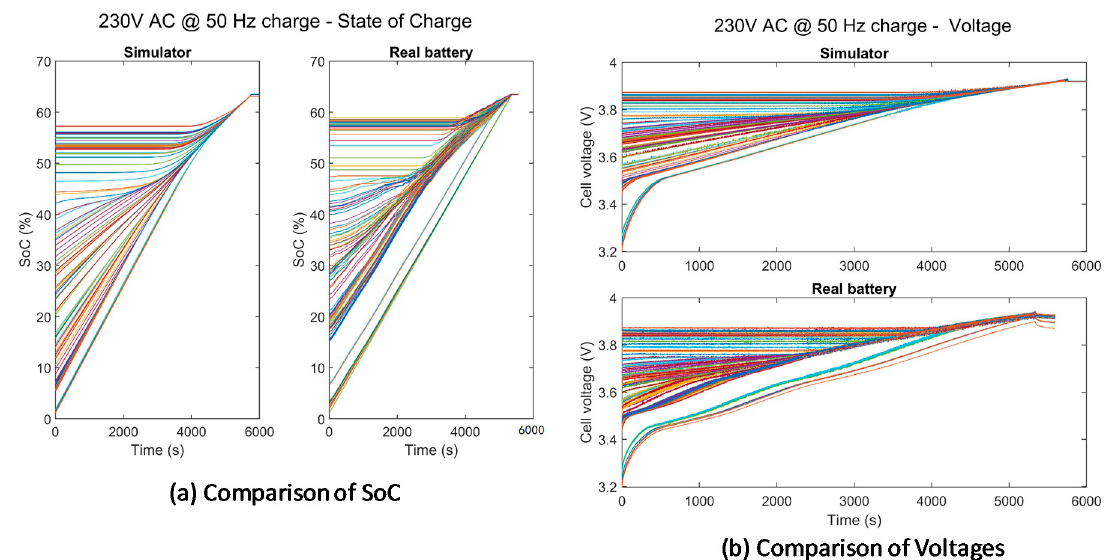
Figure 8. Simulated and experimental results of the HF SRB charging over the national power grid with a 56% initial State of Charge (SoC) unbalancing.